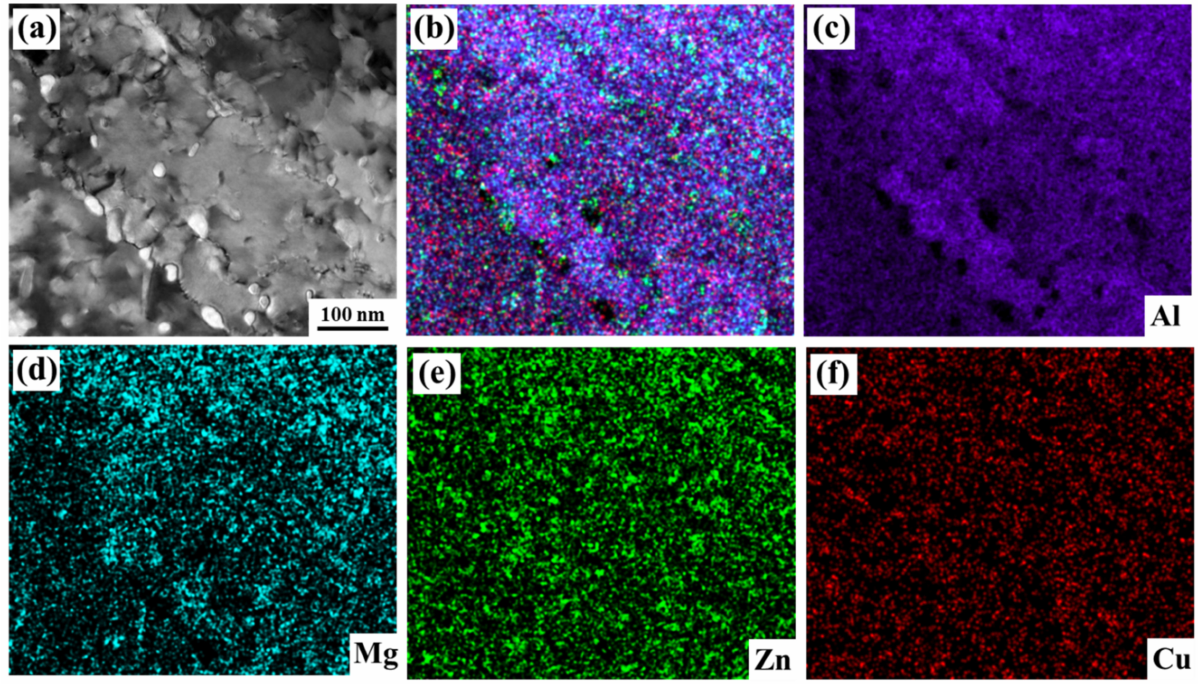
Figure 4. STEM images of 150 ◦ C-annealed alloy: ( a ) BF STEM image, ( b – f ) EDS results corresponding to ( a